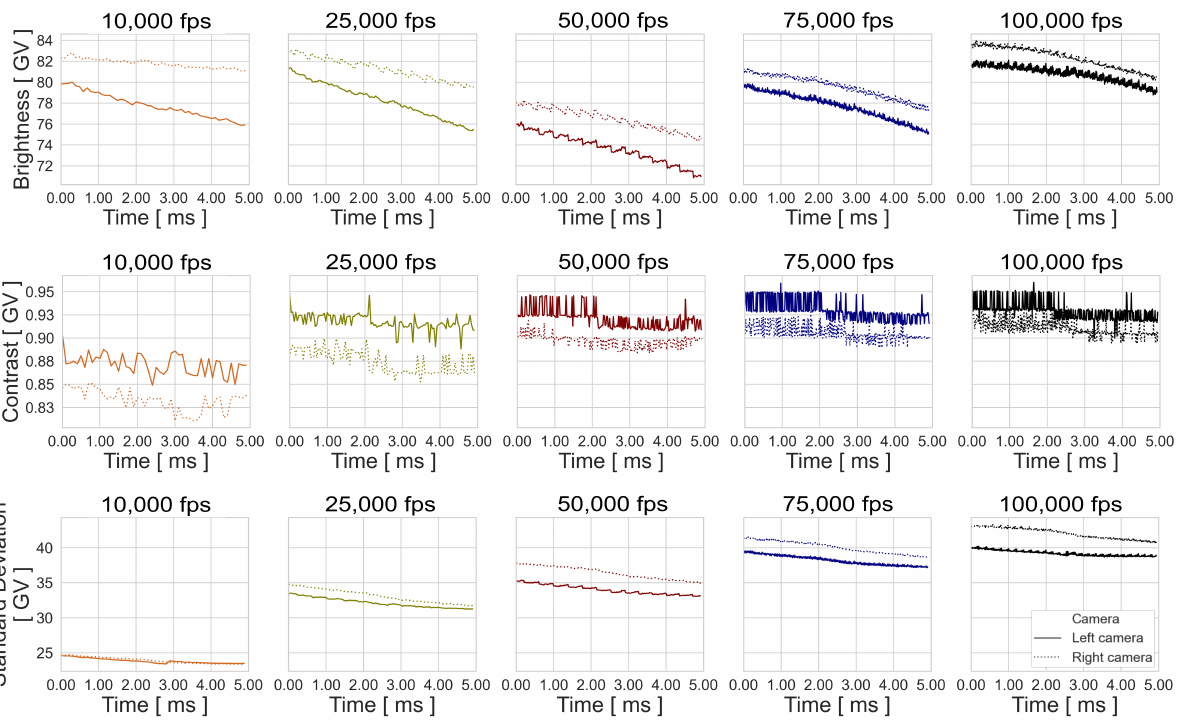
Figure A5. B P , C P , and Std P of experiment configurations images: Dynamic, 03 height, and RP 06.